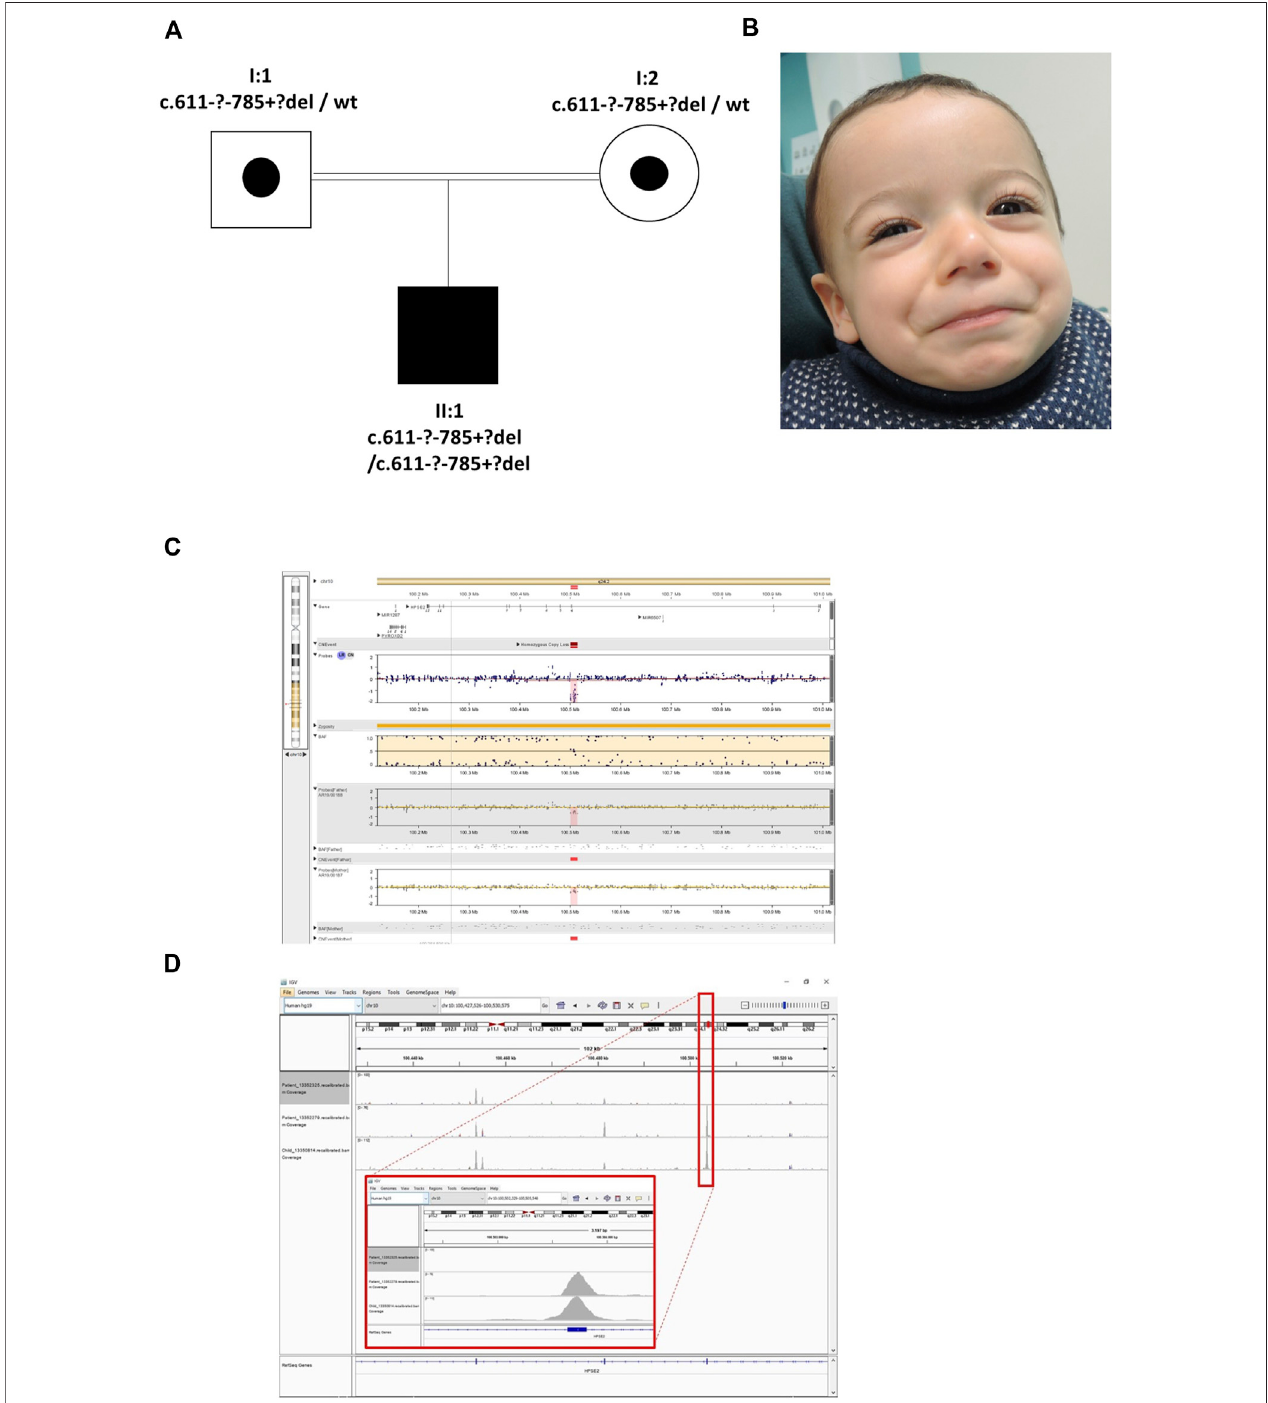
FIGURE 3 | Family 3. (A) . Pedigree of the Family 3 with individual affected with UFS (shaded). Dots represent clinically unaffected individuals proven to carry a HPSE2 heterozygousvariant. (B) .Facialappearanceofchilddemonstratingdownturnedcornersofthemouthwhensmiling. (C) .TheSNParrayshowstheproband(top track) with the father and mother below, both with a heterozygous deletion. The BAF (B allele frequency) panel of the picture shows a part of the region of homozygosity (markedyellow)andintheprobestrackthehomozygousdeletion depictedinpink/red. (D) .TheIGVimageshowsthecoverageoftheWESzoomed toencompass HPSE2 exon 4. The top track is the proband with the homozygous deletion (no coverage of exon 4). The two tracks below are two control individuals in the same WES capture/sequence run demonstrating exon coverage.